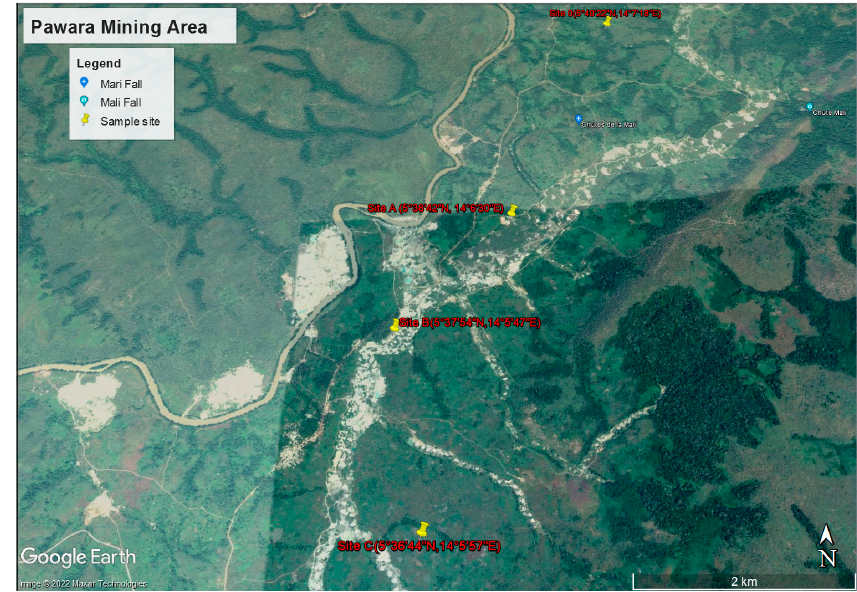
Figure 2. Satellite image showing the location of investigated sites.